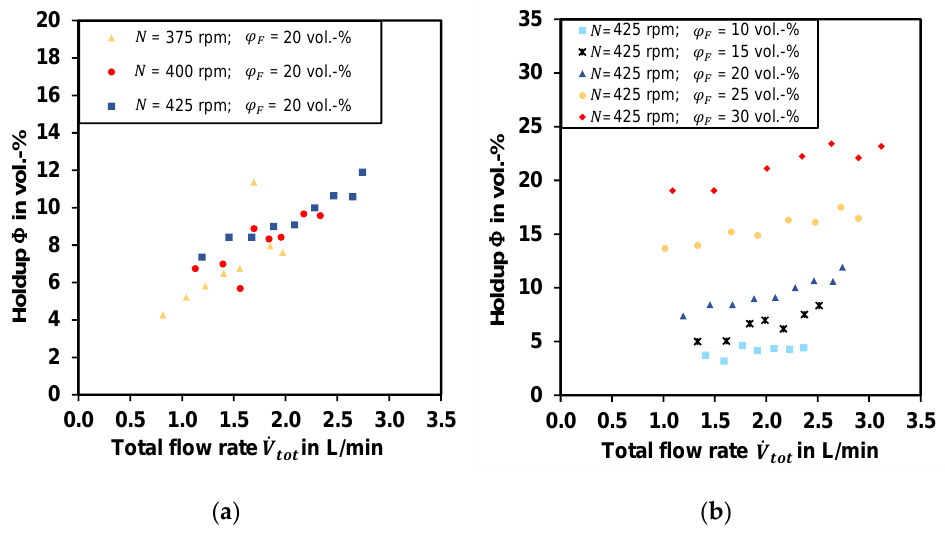
Figure 7. ( a ) Measured local holdup at the position MP H at different impeller speeds and a feed phase ratio ϕ F = 20 vol.-%; ( b ) measured local holdup at the position MP H at a constant impeller speed N = 425 rpm and different feed phase ratios.